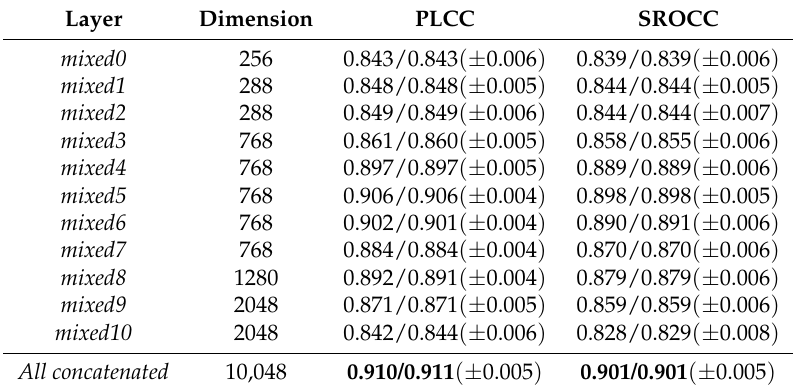
Table 3. Performance comparison of deep features extracted from Inception-V3’s [32] Inception modules without fine-tuning measured on KonIQ-10k [33]. Average/median ( ± std ) values are reported over 20 random train–test splits. The best results are in bold